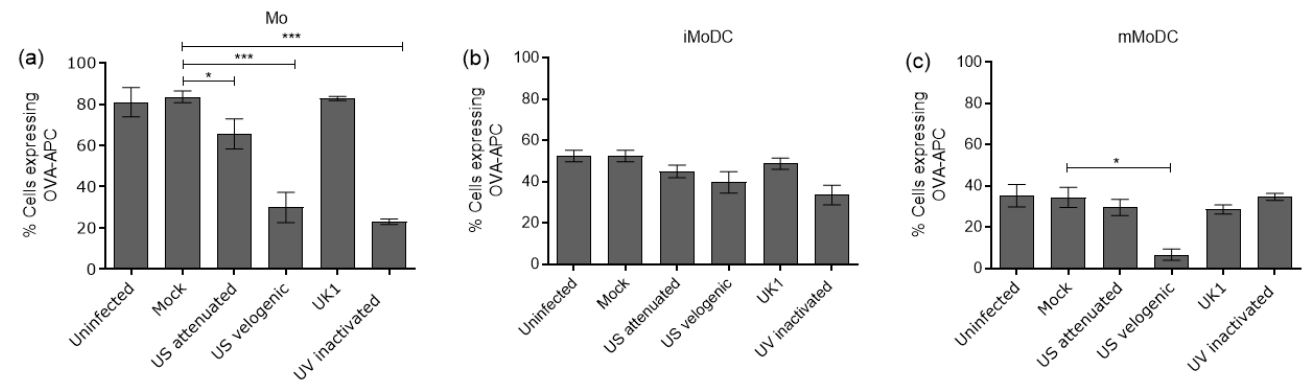
Figure 8. The capacity of EAV infected equine Mo and MoDC to endocytose antigen. Mo, immature MoDC (iMoDC) and mature MoDC (mMoDC) were inoculated at MOI of 5 with different strains of live or UV inactivated EAV. The percentage cells expressing OVA-APC* represented the difference in values obtained between the 37 ◦ C and 4 ◦ C (control). There were significant differences in the endocytic capacity of Mo and mMoDC infected with the Velogenic strain ( a , c ). There were no significant differences in the endocytic capacity of iMoDC infected with different EAV strains ( b ). The UV inactivated virus significantly reduced the uptake of OVA-APC* by Mo. Results are represented as the percentage positive cells ± SEM ( n = 6). A 1-way ANOVA with Dunn’s post-test was used to compare replicate means. * and *** indicate significant differences between sample means where p < 0.05 and 0.0001, respectively.